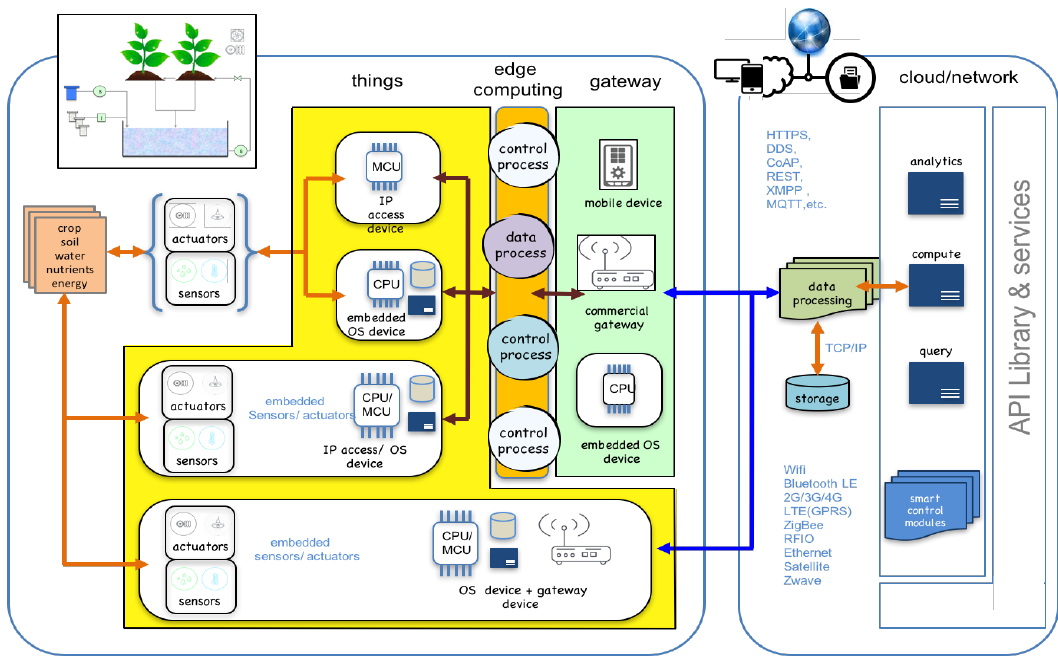
Figure 4. IoT ecosystem developed. Sensors, actuators and IP access devices make up the ubiquitous thing